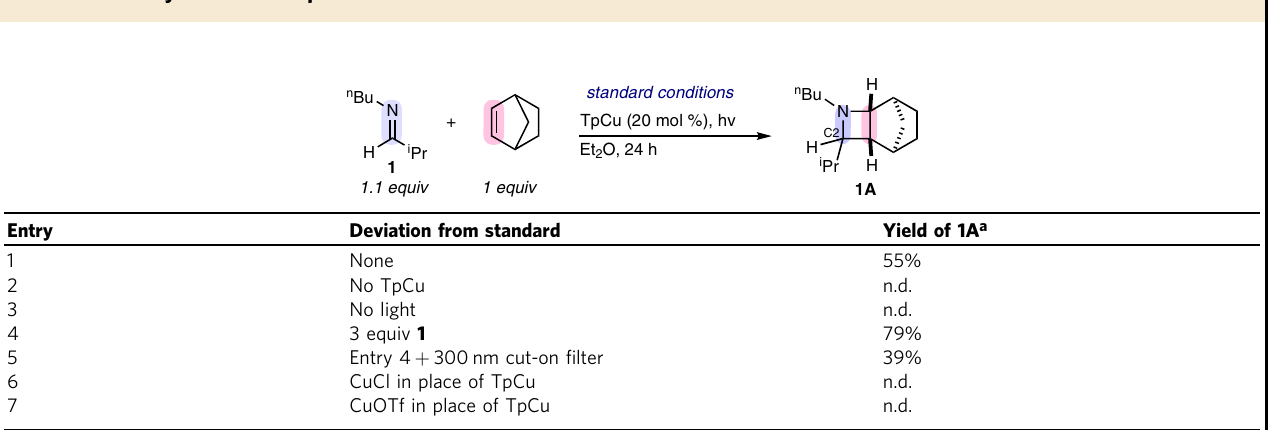
Table 1 Summary of reaction optimization studies.